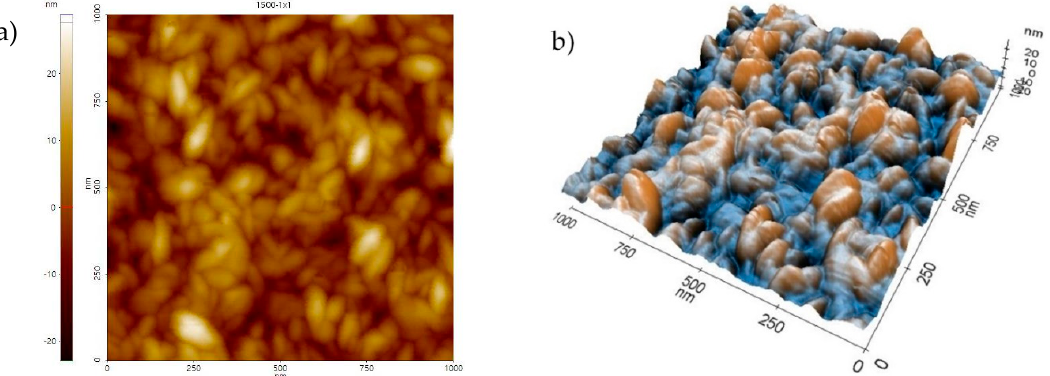
Figure 3. AFM scan of the surface morphology from a 1 × 1 µm 2 area of samples with the ZnO coating deposited in 1500 ALD cycles; ( a ) 2D view, ( b ) 3D view.